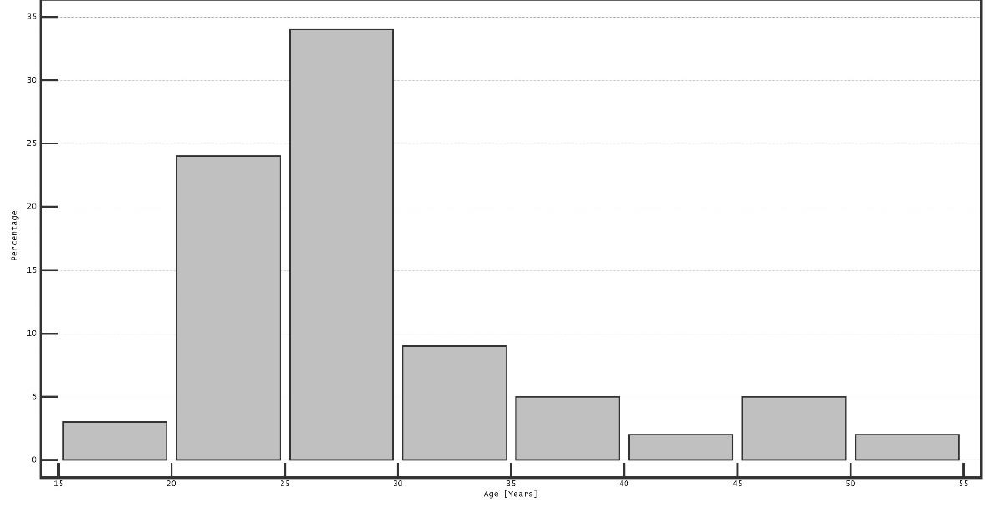
Figure 2. Age distribution of the